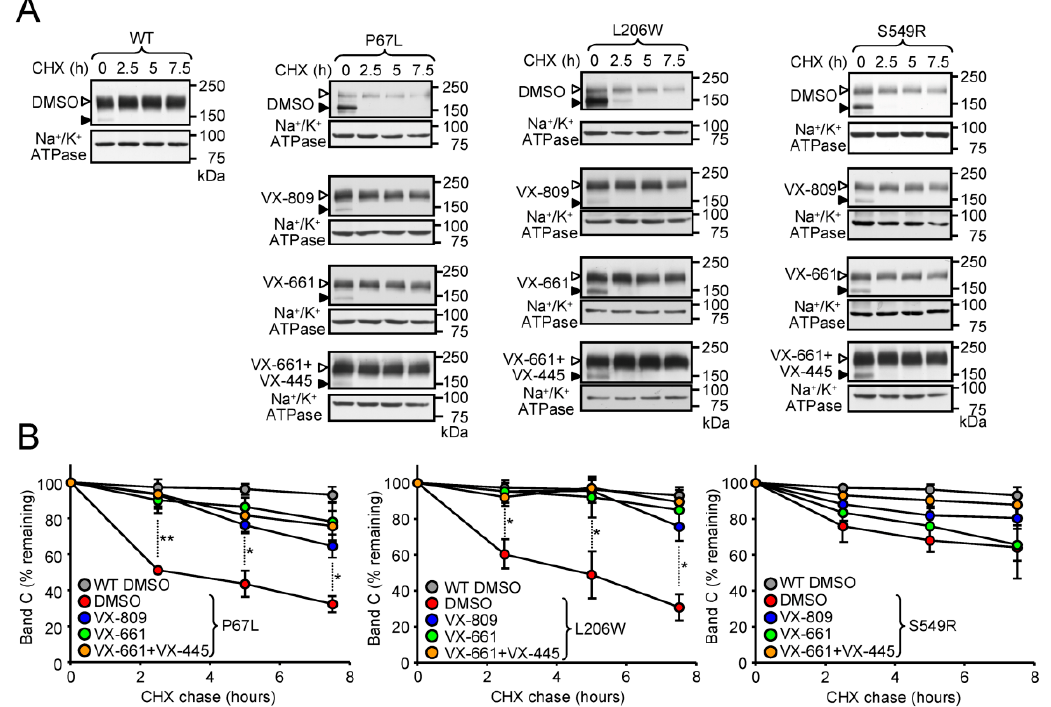
Figure 2. Effect of correctors on the metabolic stability of P67L-, L206W- and S549R-CFTR. ( A ) Metabolic stability of the WT and CFTR mutants was measured by CHX chase at 37 °C and immunoblotting with anti-HA antibody in CFBE cells pre-treated for 24 h with the indicated compounds. Anti-Na + /K + -ATPase served as loading control. The empty arrowheads indicate the mature, complex-glycosylated CFTR (C-band), and the filled arrowhead show the immature, core-glycosylated protein (B-band). ( B ) Remaining complex-glycosylated CFTR was quantified by densitometry and expressed as a percentage of the initial amount ( n =3). Data in B are means ± SEM of three independent experiments. * p < 0.05, ** p < 0.01 by Student’s t -test.